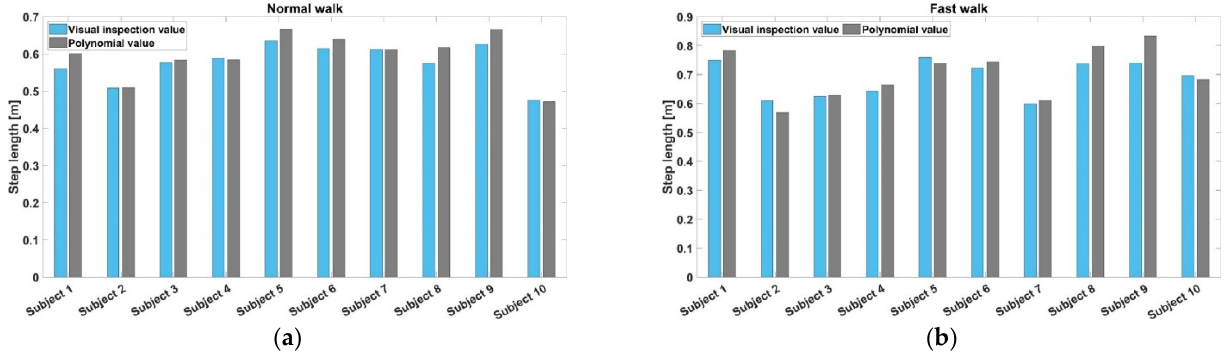
Figure 11. Foot position during walking.